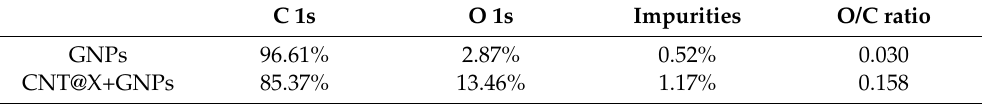
Table 2. Atomic concentration of elements in GNPs and CNT@X+GNPs.